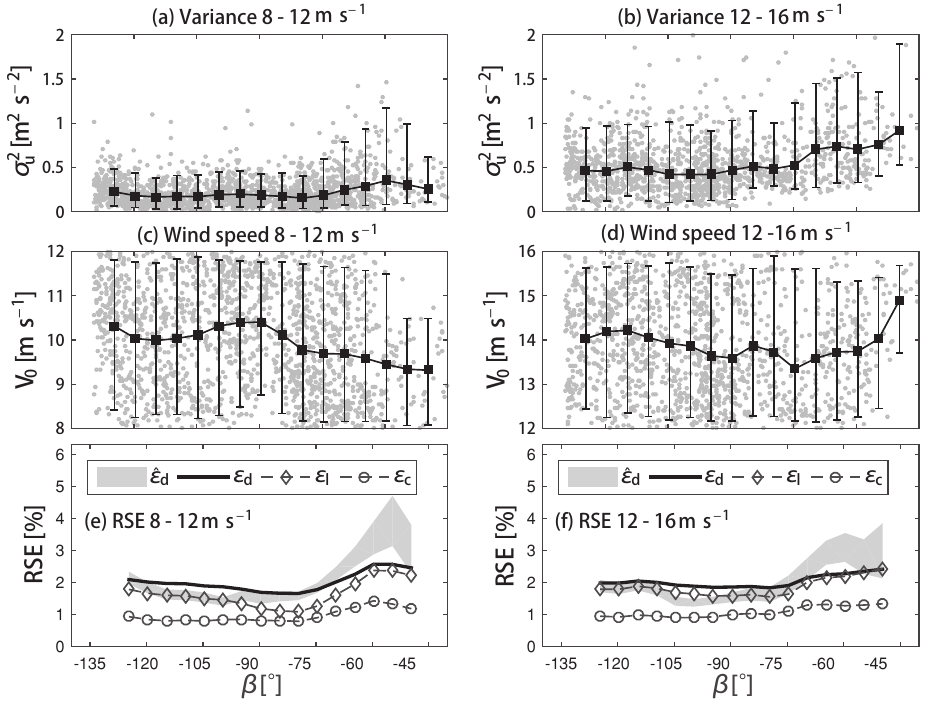
Figure 7. Variation of the standard error (RSE) with the relative direction ( β ) at Site B for the wind speed bin 8–12ms − 1 in (a, c, e) and the wind speed bin 12–16ms − 1 in (b, d, f) . The RSE is given in (e, f) for the 95% confidence interval of the observed difference between the cup and lidar measurements ( ˆ ε d ), the predicted difference between the cup and lidar measurements ( ε d ), the predicted cup error ( ε c ), and the predicted lidar error ( ε l ). The input for the RSE predictions include the mean wind speeds ( V 0 ) shown in (c, d) and the mean wind speed variance ( σ 2 u ) shown in (a, b) for the wind speed bin 8–12 and 12–16ms − 1 ,